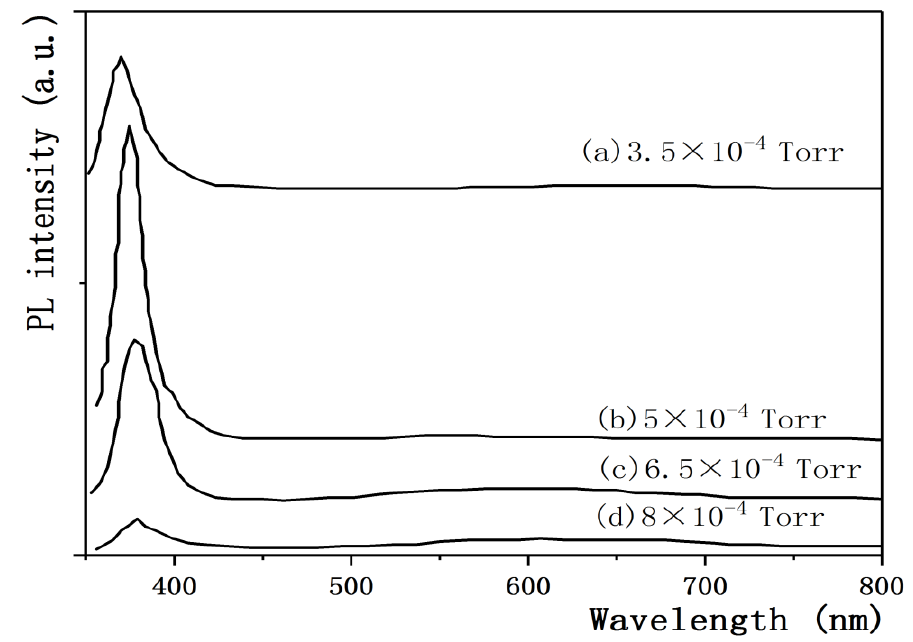
Figure 10. The photoluminescence spectra of ZnO thin films grown at different oxygen partial pressures [110].